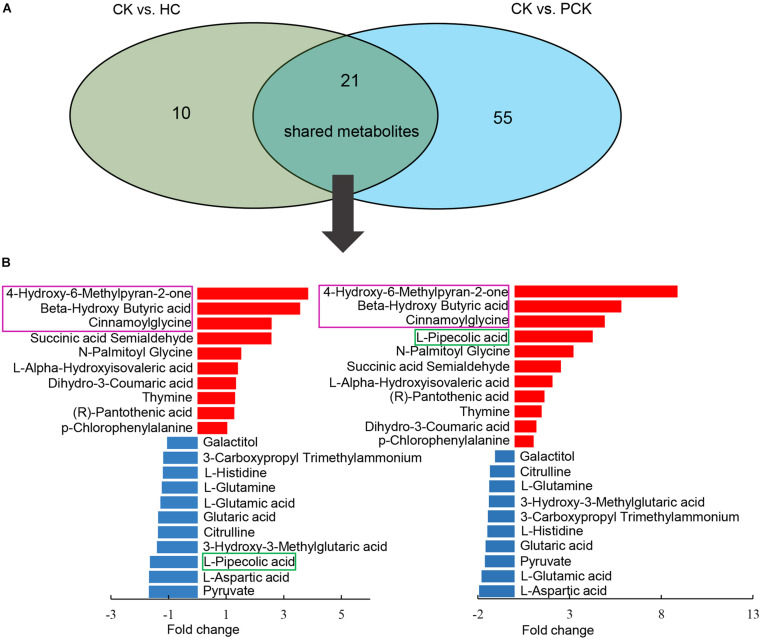
Comparison of metabolite profiling between CK vs. HC and CK vs. PCK. (A) 21 shared metabolites from these two comparisons were identified and which showed similar up- or down- accumulated pattern but L-Pipecolic acid. (B) Bar plot (left) showed the fold change of shared metabolites in CK vs. HC and (right) CK vs. PCK, of which, red represents high and blue represents low in CK group.